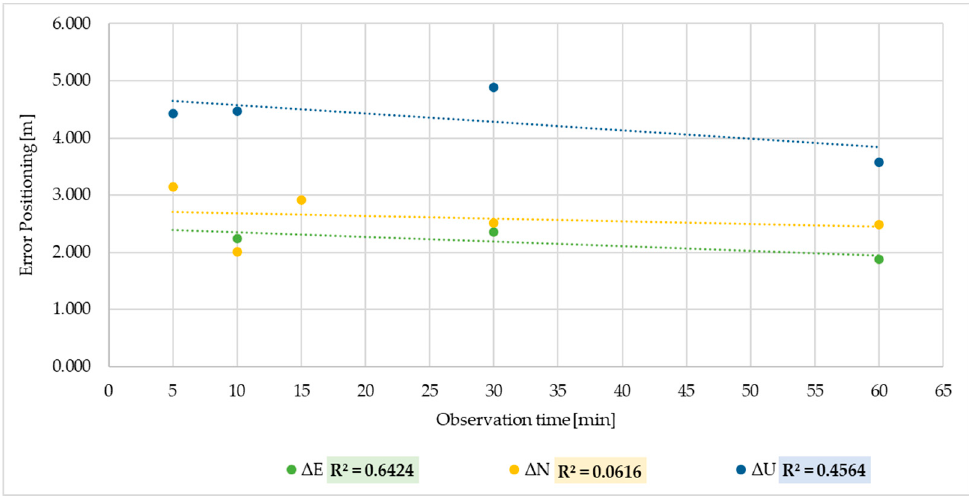
Figure 4. Linear regression between Δ E, Δ N and Δ U DGNSS error positioning and observation time.